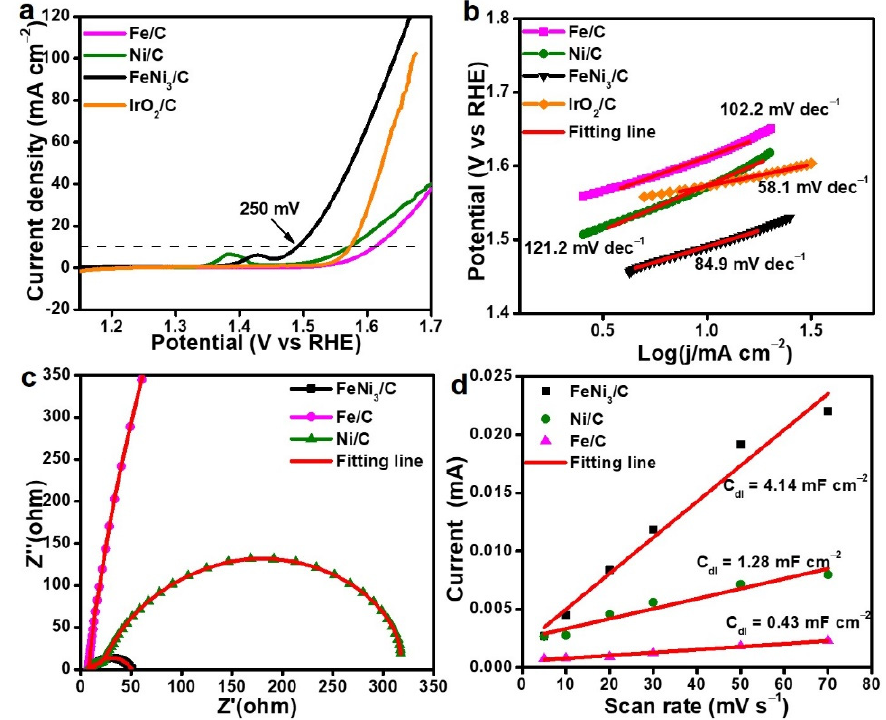
Figure 3. ( a ) Polarization curves of FeNi 3 /C, IrO 2 /C, Fe/C, and Ni/C nanorods at 5 mV s − 1 ; ( b ) Tafel slopes of FeNi 3 /C, Fe/C, Ni/C, and IrO 2 /C; ( c ) Nyquist plots; ( d ) C dl values of FeNi 3 /C, Fe/C, and Ni/C nanorods.